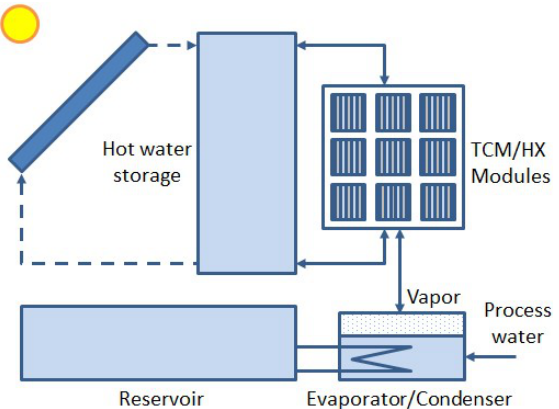
Figure 1. Elementary thermochemical heat storage (THS) system. The core of the system is a reactor containing modules with thermochemical material (TCM), e.g., a hydrated salt. The salt is dried by solar heat of, e.g., 80–90 ◦ C, captured by a solar collector, buffered in hot water storage and transferred by a heat exchanger (HX). Process water from dehydrating the salt is captured in a pool which acts as a condenser during dehydration and as an evaporator during hydration. Process water is kept at 10–20 ◦ C by an HX with a reservoir which may be a borehole energy storage (BES).